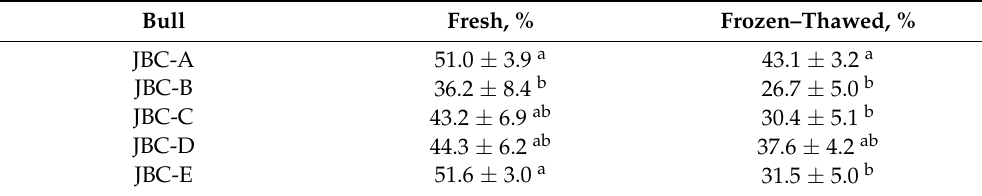
Table 3. Vitality of fresh and frozen–thawed 7 cm sperm from individual JBC bulls, as assessed by eosin–nigrosin staining.